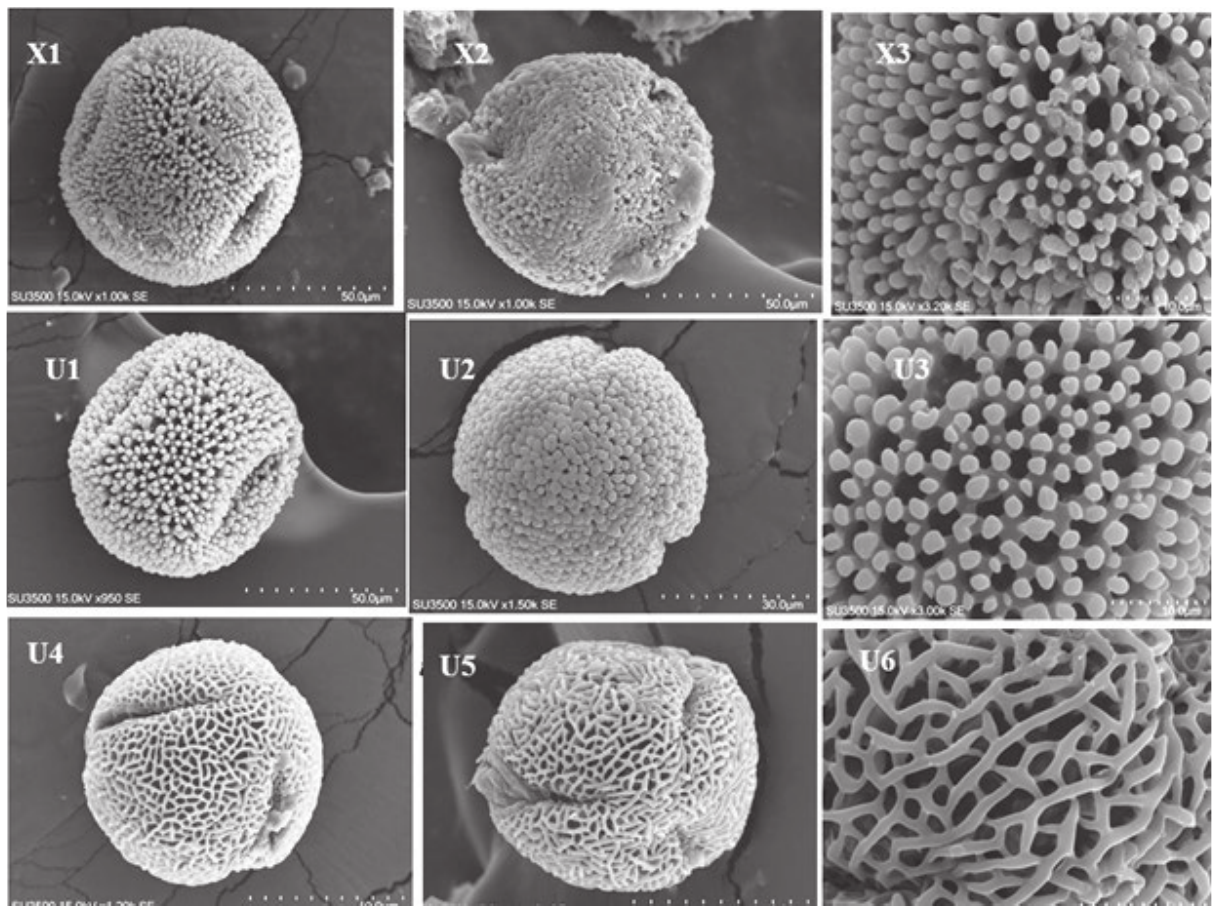
Figure 7. Pollen micrographs of Geranium species:X1-X3: G. ibericum, U1-U3: G. tuberosum, U4-U6: G. biuncinatum. X1,U1, U4 – equato- rial view; X2, U2, U5- polar view; X3, U3, U6-exine